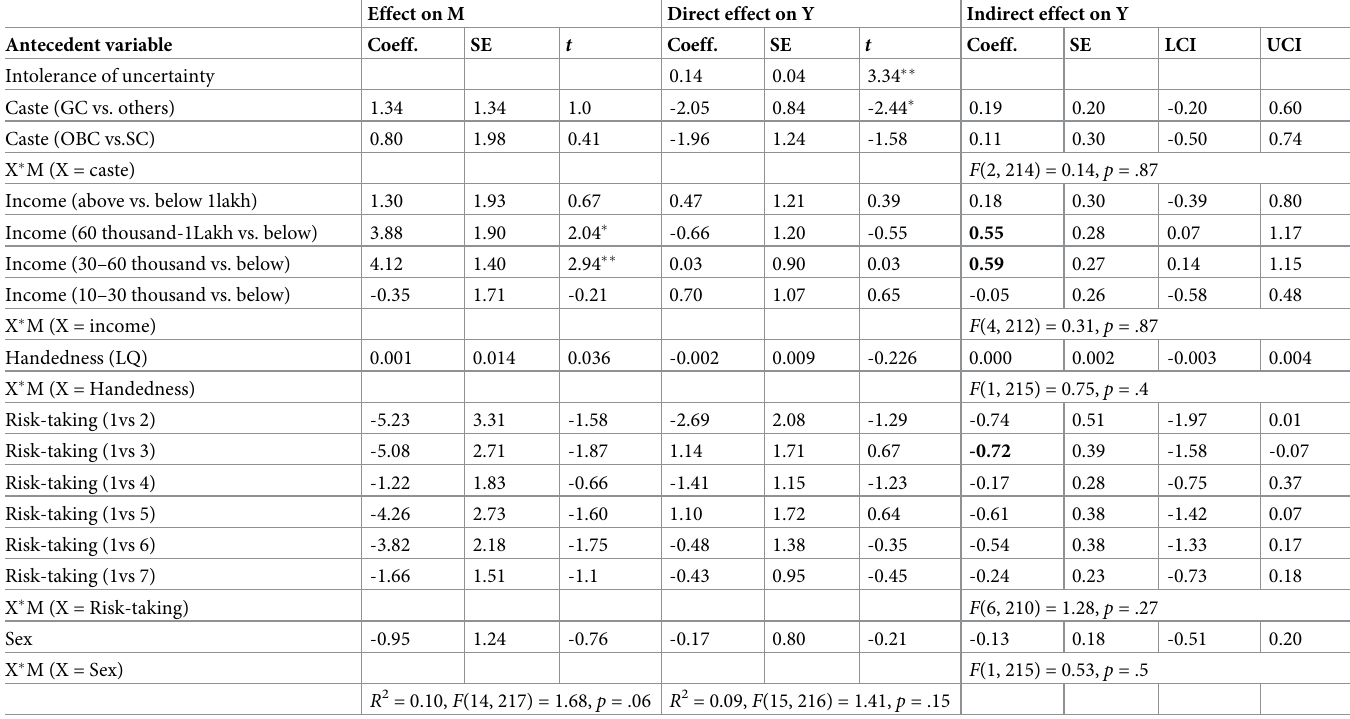
Table 16. The effects (direct and indirect effect) of antecedent and mediation (general IU) variables on belonging in the community